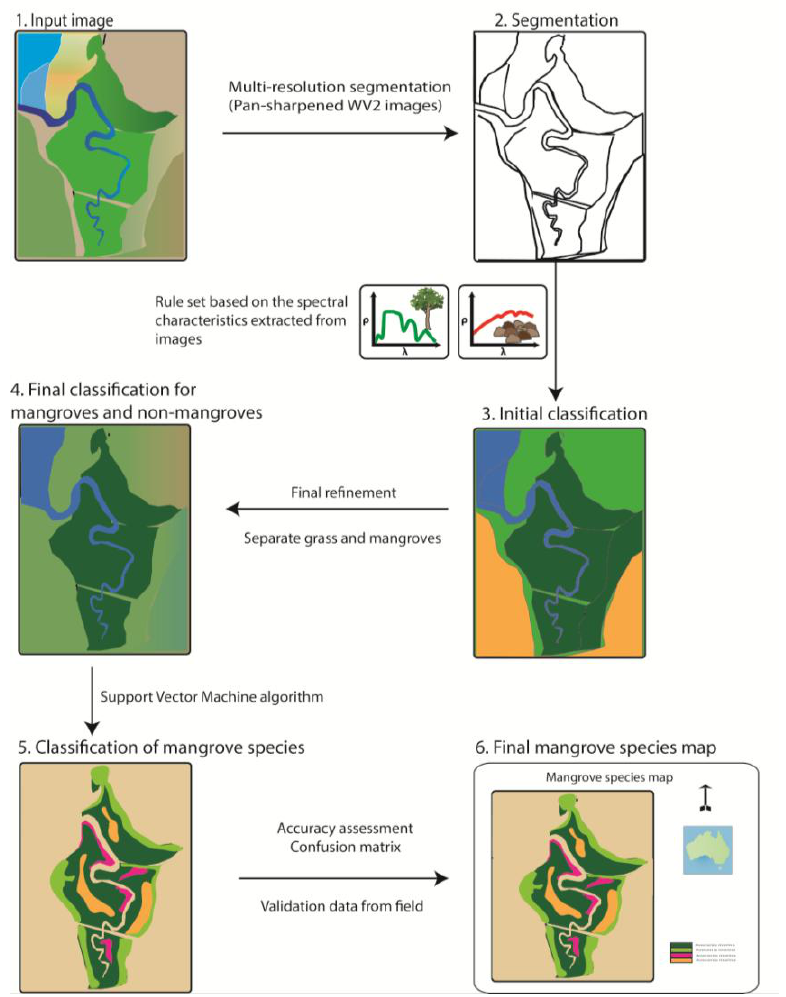
Figure 2. Mangrove species mapping using remotely sensed data. Image segmentation and initial classification was completed in eCognition Developer 8.7 software. The support vector machine algorithm was implemented in the ENVI-IDL environment for species